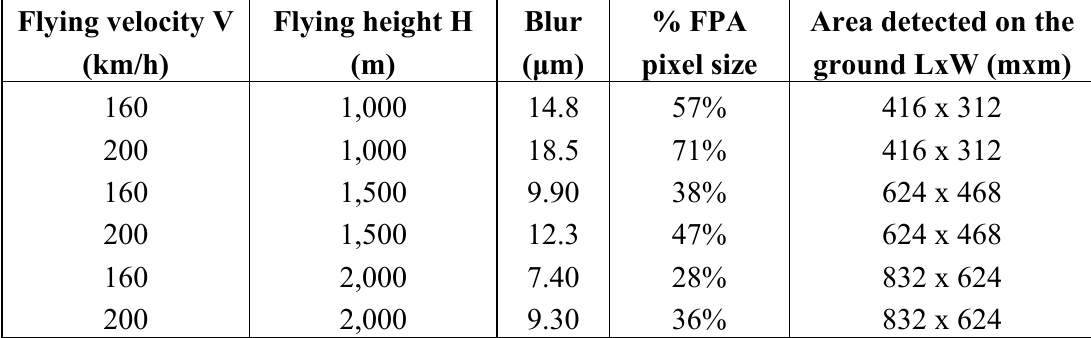
Table 2 . SITHON forward motion blur for different combinations of flying velocity